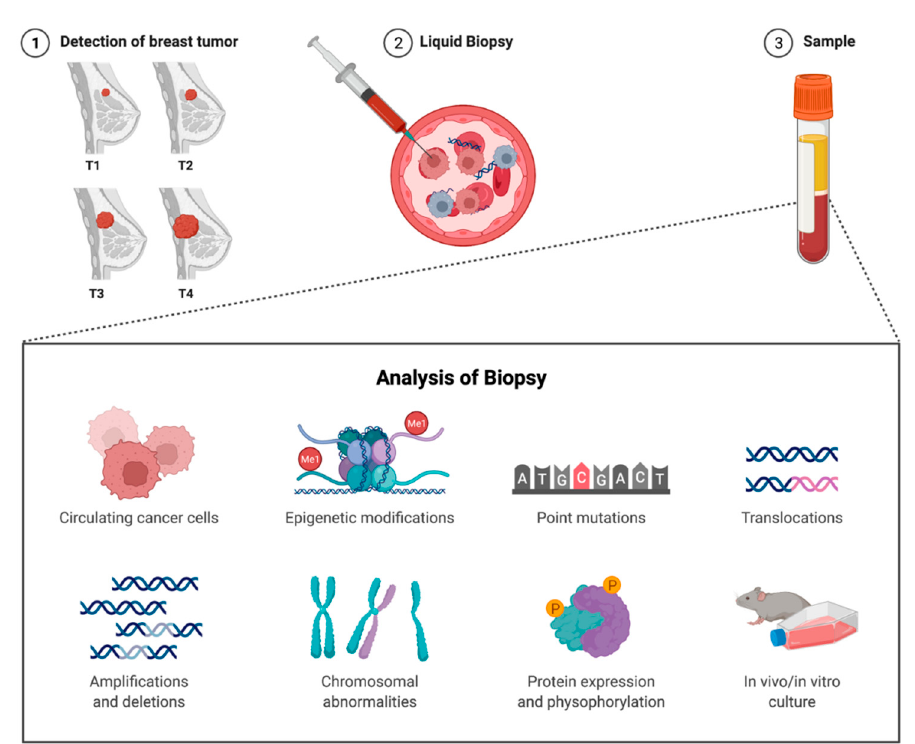
Figure 4. Overview of Liquid Breast Cancer Biopsy . ( 1 ) Breast cancer is detected either clinically or radiologically, ( 2 ) Liquid breast cancer biopsy is performed, ( 3 ) Samples can be analyzed for circulating cancer cells, epigenetic modifications, point mutations, translocations, amplifications and deletions, chromosomal abnormalities, protein expression and phosphorylation, and in-vivo/in vitro culture. Adapted from the following references [99,100,104].